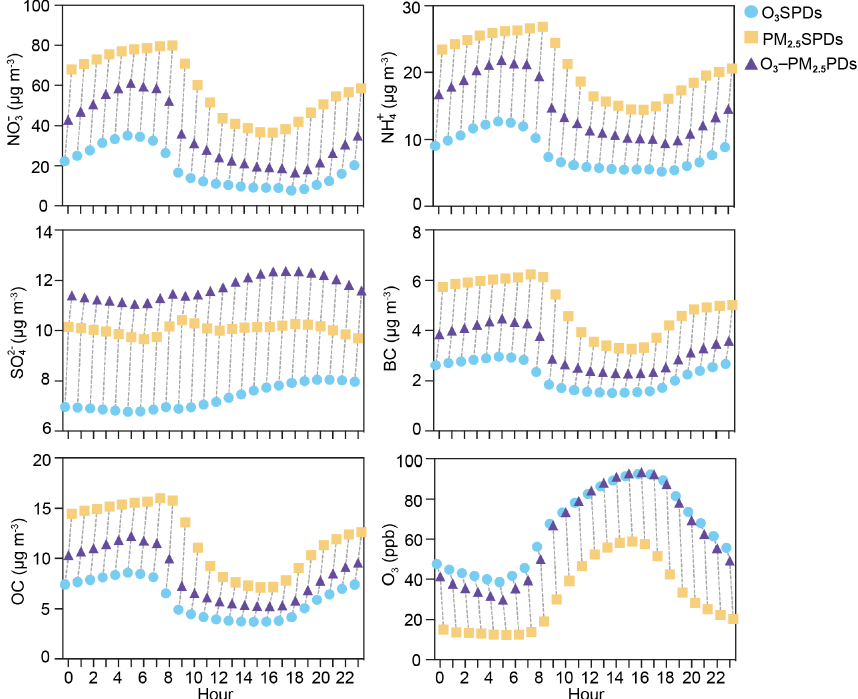
− , NH + , SO 2 − , BC, OC, and O 3 averaged over the model-captured O 3 SPDs, PM 2 . 5 SPDs, and 3 4 4